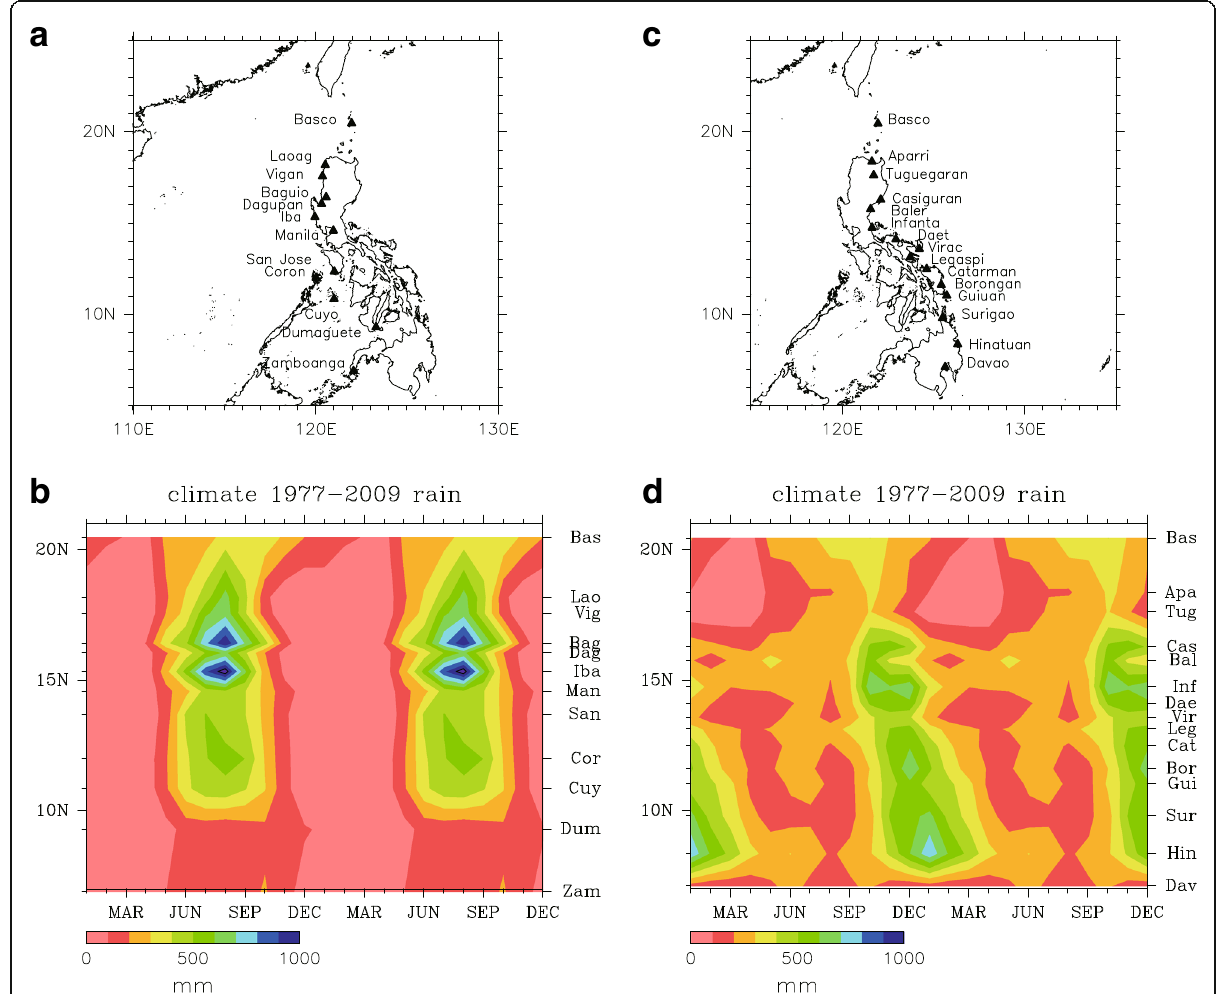
Fig. 3 Climatology of the western and eastern sides of the Philippines rainfall. a , c Station locations and b , d climatology of monthly rainfall distribution along the western and eastern sides of the Philippines during the period 1977 –